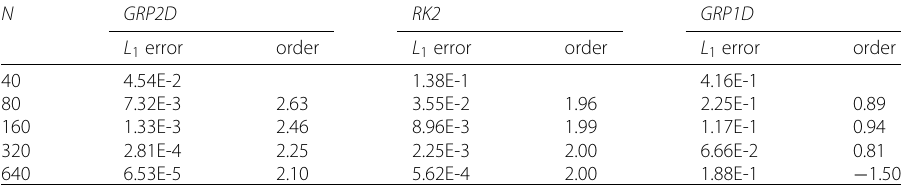
Table 1 L 1 error and convergence order of u for the periodic wave problem at final time t = 2 with the methods GRP2D , RK2 and GRP1D N GRP2D RK2